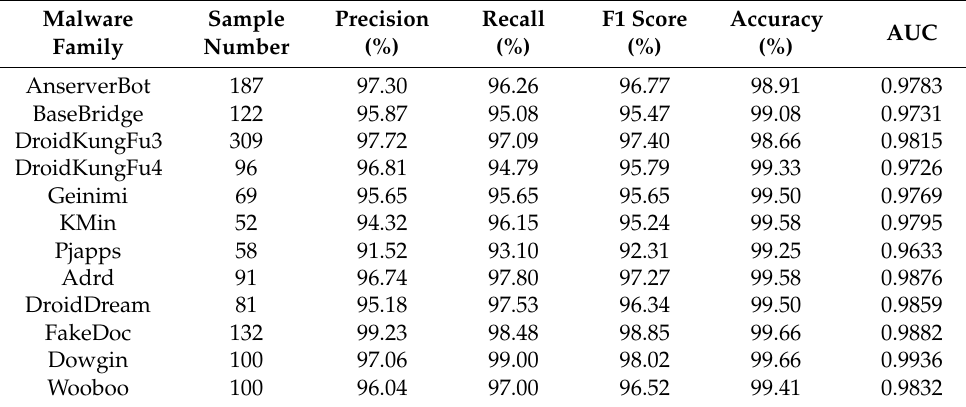
Table 4. Classification results of large families with